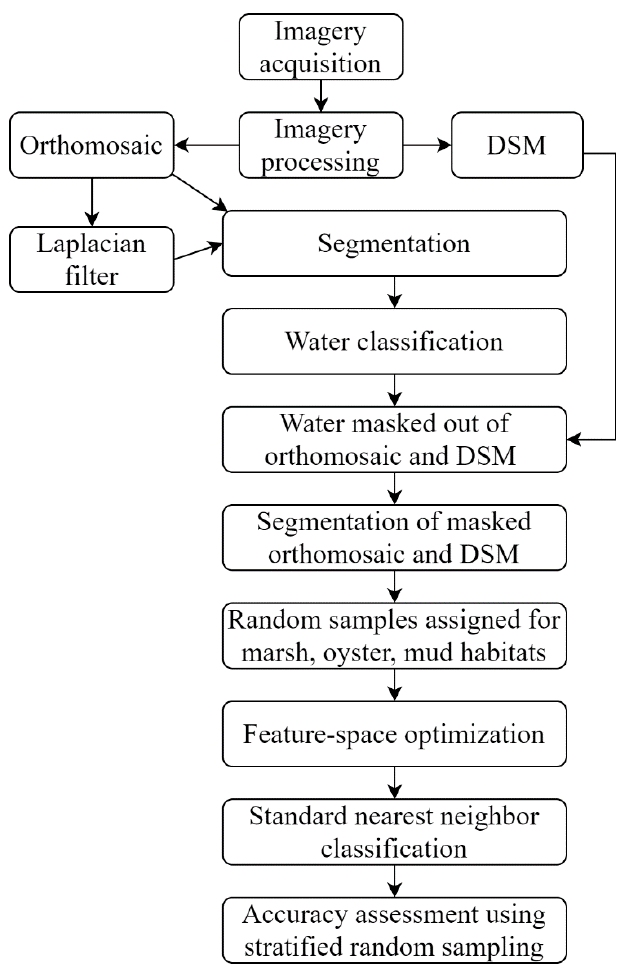
Figure 4. Workflow diagram detailing imagery and geographic object-based image analysis processing.